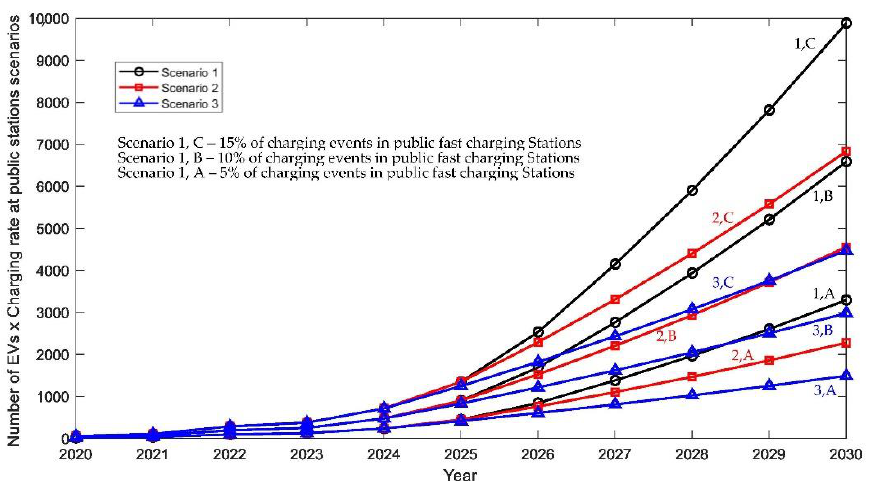
Figure 9. Projection scenarios for vehicles combined with scenarios of use of public EV fast charging stations.